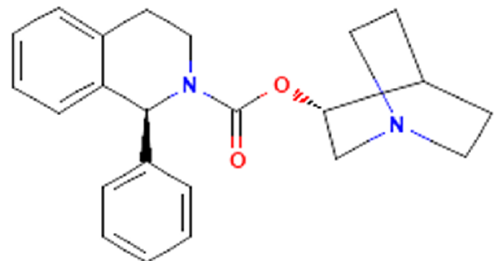
Figure 1. Chemical structure of solifenacin (Vesicare ® , [(3R)-1-azabicyclo [2.2.2]octan-3-yl] (1S)-1-phenyl-3,4-dihydro-1H-isoquinoline-2-carboxylate, 2(1H)-isoquinolinecarboxylic acid, 3,4-dihydro- 1-phenyl-,1-azabicyclo(2.2.2.)oct-3-yl ester, (R-(R*,S*))-905, quinculidin-3′-yl-1-phenyl-1,2,3,4-tetra- hydroisoquinoline-2-carboxylate).